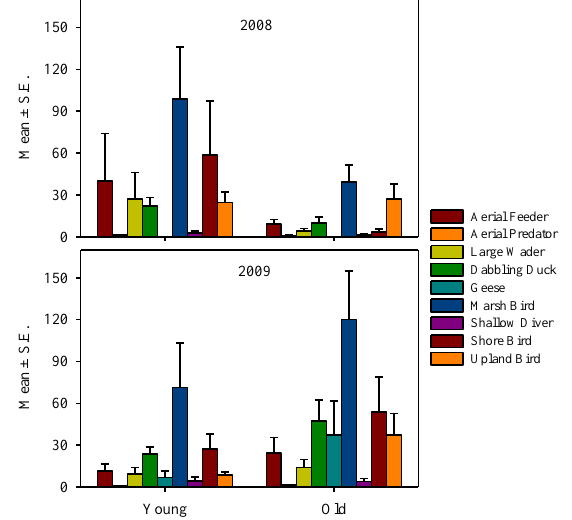
Figure 3. Average abundance of eight bird foraging guilds observed (wetland surveys) on wetland areas of Wetlands Reserve Program easements in three California Central Valley sub-basins, Sac = Sacramento, San = San Joaquin and Tul = Tulare. The Tulare sub-basin was not sampled in the year 2009. Foraging guilds are comprised of species that share behavioral traits and have similar environmental requirements [13]. Standard error bars are shown.